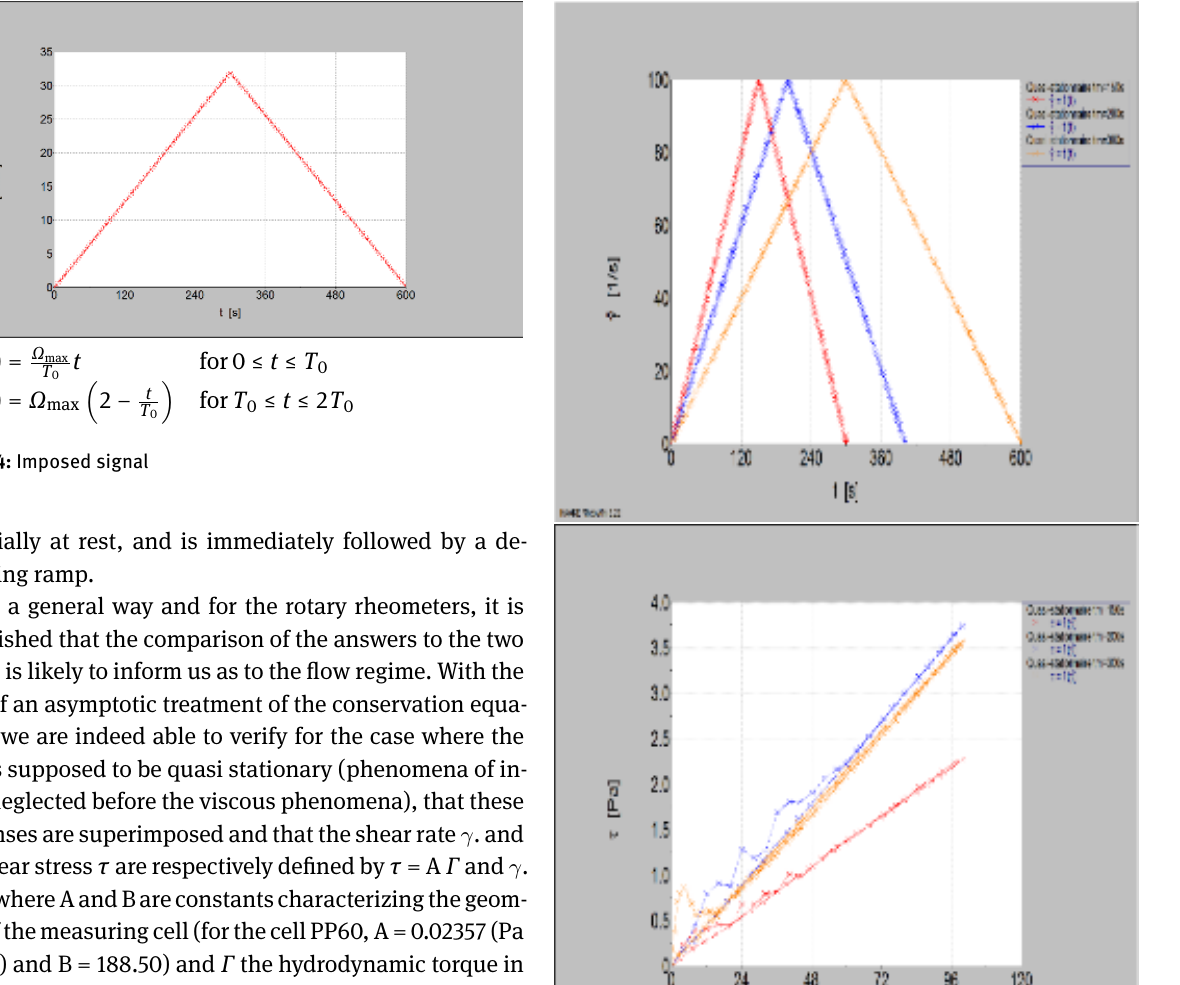
is initially at rest, and is immediately followed by a de- scending ramp.